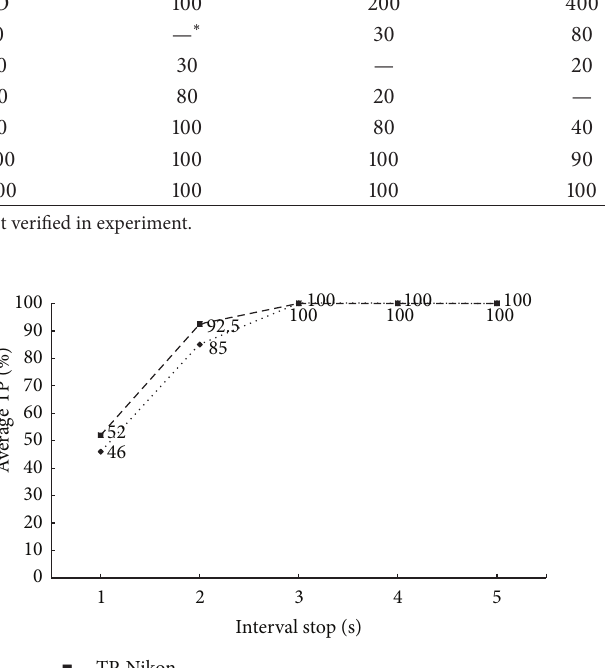
Table 5: Combination of ISO speed and respective TP rate. Source pictures are taken by Canon 550D.